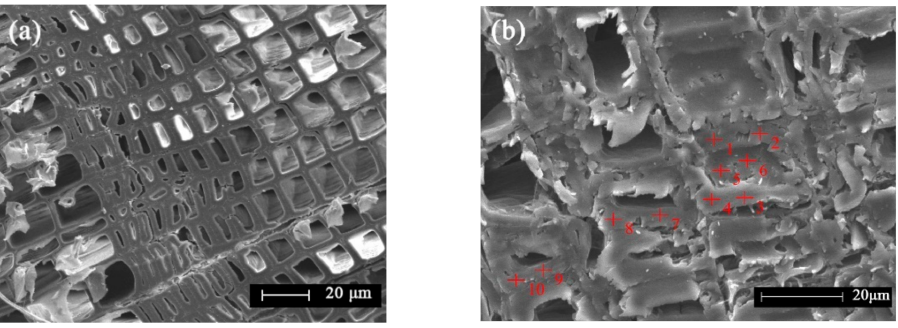
Figure 5. ESEM image of the control samples ( a ) and PF-1-Cu samples ( b ).